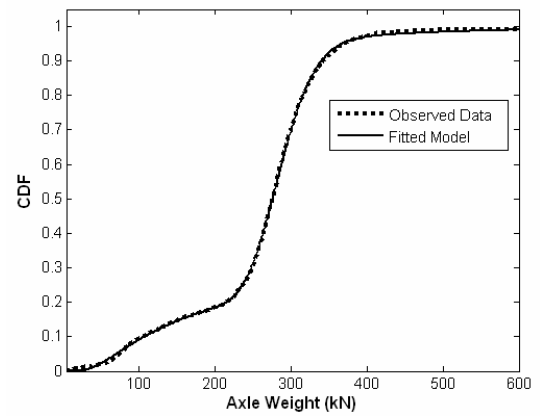
Fig 5. Typical CDF plots of observed and fitted